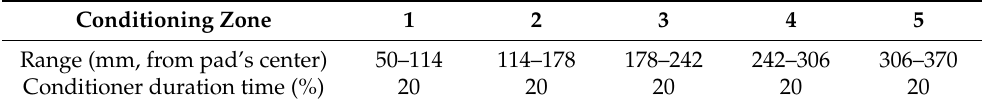
Table 2. Swing condition of conditioner.